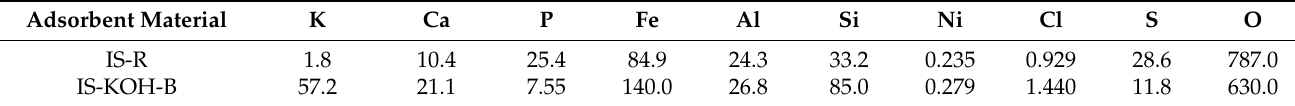
Table 1. Mineral composition of IS-R and IS-KOH-B (mg g − 1